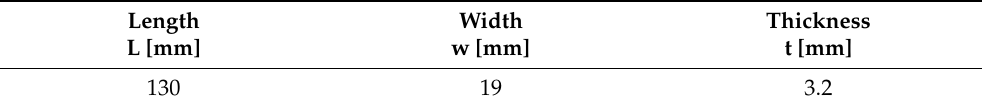
Table 1. The dimensions of specimens subjected to three-point bending.